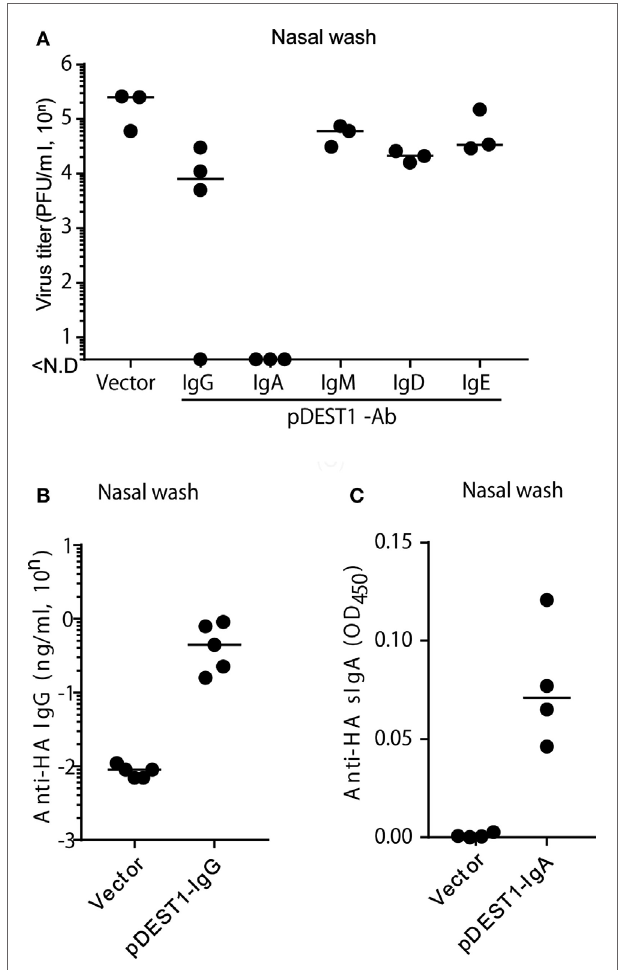
FigUre 6 | HD protects mice from influenza virus infection in the upper respiratory tract. (a) HD was conducted in BALB/c mice 8 h after intranasal infection (1,000 PFU/2 μ l, each nostril). At 3 days post-infection, the virus titer in nasal wash specimens was determined by an MDCK plaque assay. Data were analyzed using a non-parametric Kruskal–Wallis test ( p = 0.0091). (B) HD for anti-HA IgG was conducted in BALB/c mice and after 1 day, nasal wash specimens were obtained under serum-excluding conditions and analyzed for the concentration of anti-HA IgG by ELISA. (c) HD for anti-HA IgA was conducted in BALB/c mice after 8 h of virus infection. At 3 days post-infection, the nasal wash was obtained and the secreted HA-specific IgA (anti-HA sIgA) level was measured by ELISA using rabbit anti-mouse polymeric Ig receptor (pIgR). Horizontal bar represents the median. The indicated data are representative of two independent